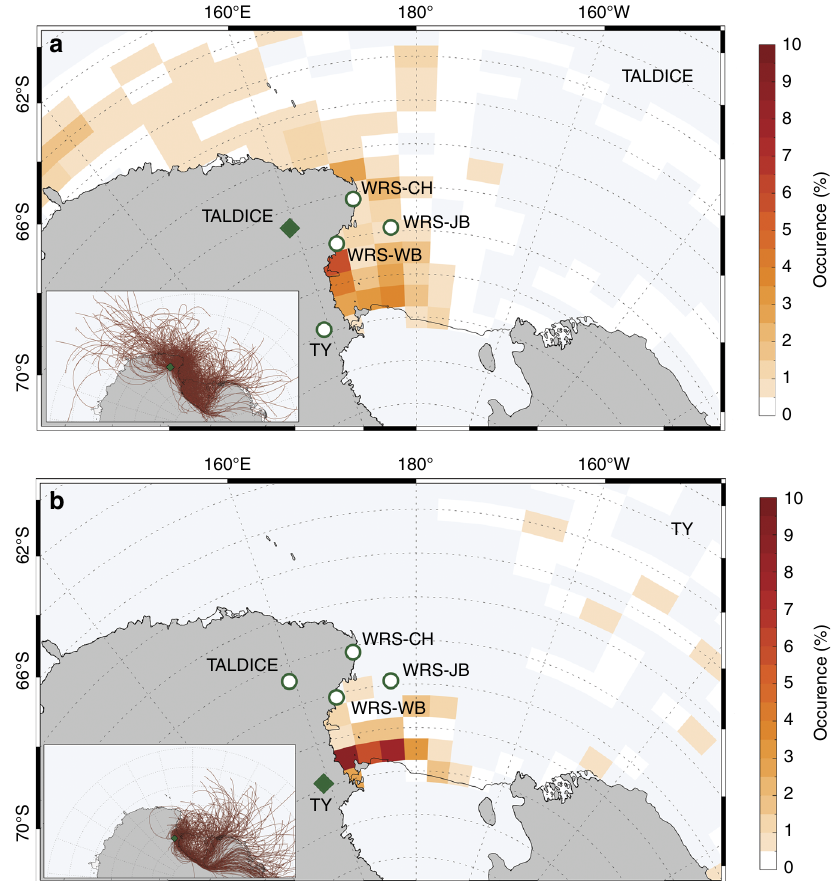
Fig. 4 Sea salt aerosol source regions and paths from sea ice area toward ice core using model air mass trajectories. a , b occurrence (%) of loading condition for selected back trajectories. Back trajectories can be considered loaded above the sea ice if they fl ow above an area with sea ice values between 15 and 75% and wind speed > 3ms − 1 . The occurrence of events is spatially cumulated for a regular grid of 5°×1° of longitude and latitude (the number of occurrences for each site is in percentage in respect to the total number of occurrences for the entire domain. The entire domain is de fi ned as: 80°S < latitude < 50°S; 0° < longitude < 180°E − 180°W. a , b Insets: 3 days back trajectories ending at 1000m over TALDICE ( a inset) and TY ( b inset) and spending more than 10% of their path over the sea and < 40% over the continent (red lines). Only trajectories related to March, April, May, June, July, August, September, October and November for the period 1979 – 2012 are considered. Among the selected trajectories, only those with a permanence of at least three consecutive hours over sea ice concentration > 15% are considered. The green open diamond represents the location of TALDICE ( a ) and TY ( b ), whereas open circles indicate the location of the three marine cores (Cape Hallett WRS_CH; Wood Bay WRS_WB and Joides Basin WRS_JB) and the other ice